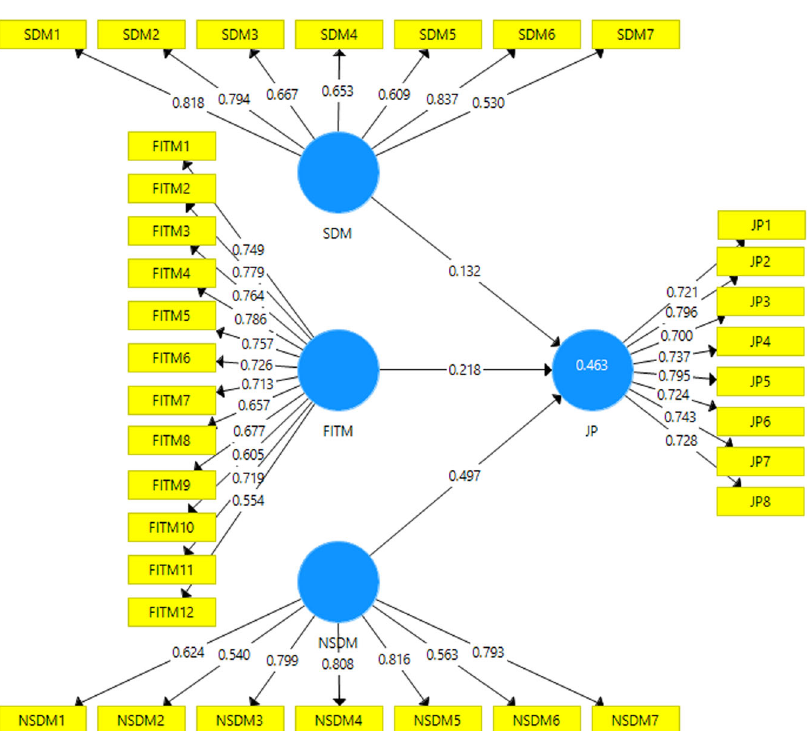
Fig. 2 Con fi rmatory Factor